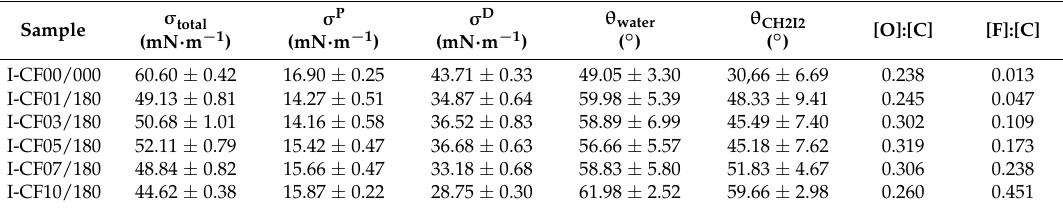
Table 3. Surface polarity of differently treated carbon fiber samples described by surface free energy (total, polar, and disperse) as well as contact angles for water and diiodomethane (CH 2 I 2 ) with variance. For comparison purposes, the elemental ratios [O]:[C] and [F]:[C] were determined by means of XPS.